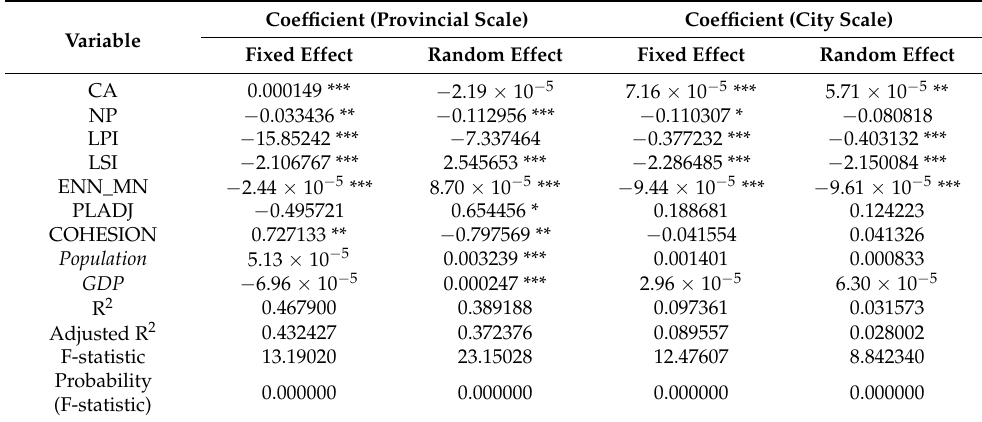
Table 5. The relationships between the UF and PM 2.5 concentration at the different scales.